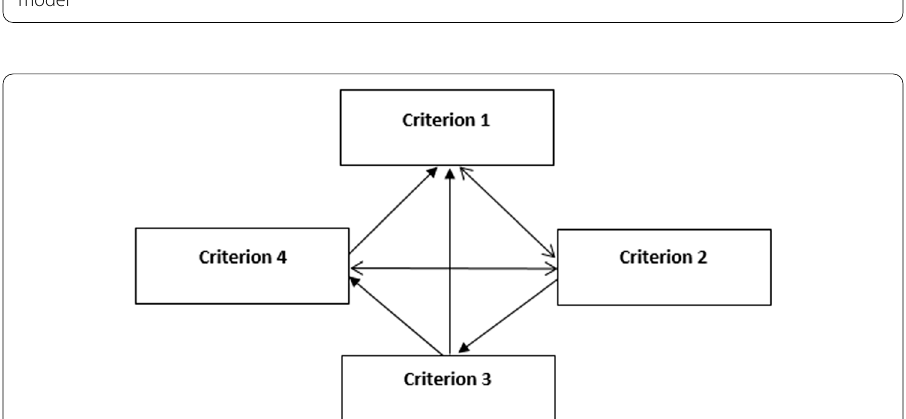
Fig. 6 Impact-relation directions of consensus-based multidimensional due diligence for rewarding